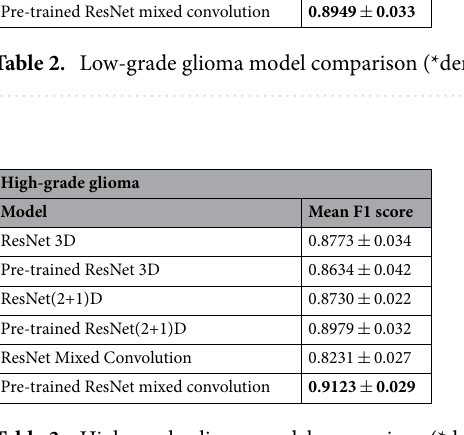
Table 3. High-grade glioma model comparison (*denotes the overall winning model).